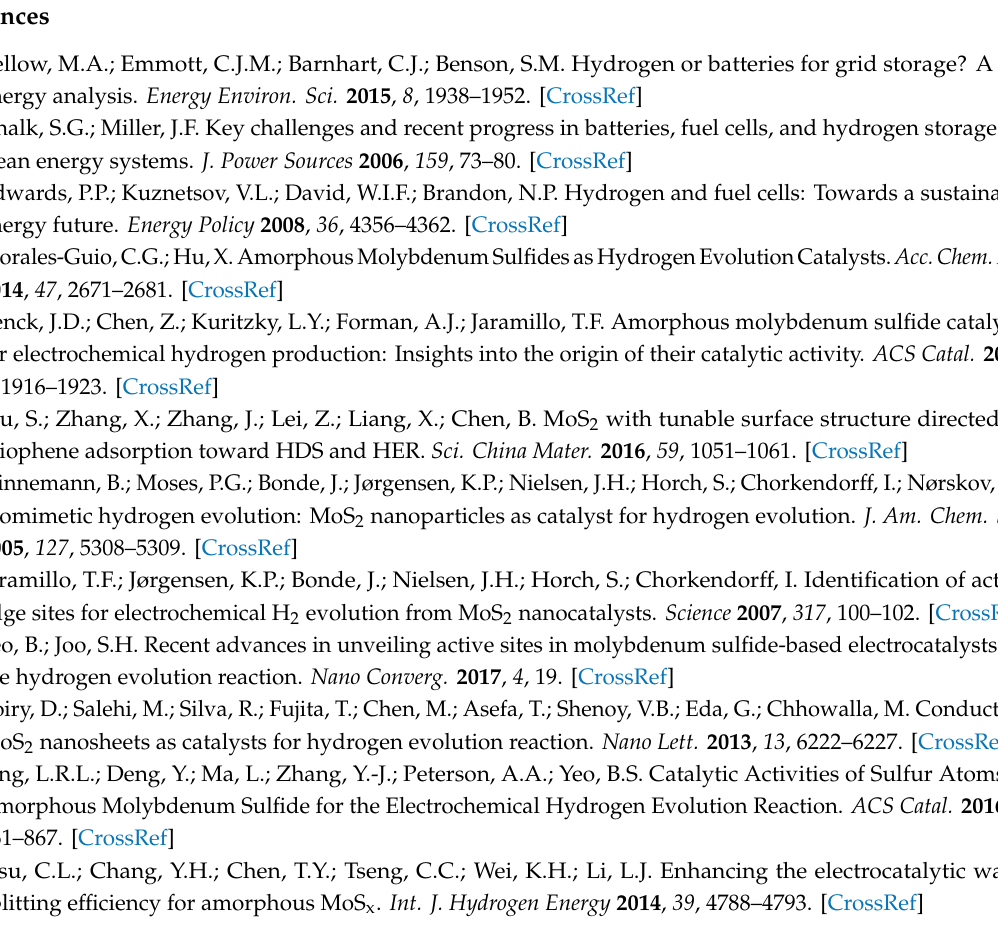
Figure S1: Rietveld refinement of MoS 2 , Figure S2: Electron di ff raction pattern of MoS 2.6 and MoS 3.4 , Figure S3: HRTEM images of MoS 2 + δ used for the lattice parameter analysis in Table S5, Figure S4: HRTEM images of MoS 2 and their FFTs, Figure S5: Reduced FFT of HRTEM image from Figure 5 A & B, Figure S6: SEM images of MoS 2 and MoS 3.4 powder, Figure S7: Cyclic voltammetry of the two MoS x samples and MoS 2 , Table S1: Comparison of d hkl from XRD and SAD from Figures 2 and 3 for MoS 2 + δ with MoS 2 , Table S2: Goodness parameters and correction factor for the texture, Table S3: Refined lattice parameters and atom positions of MoS 2 , Table S4: Overview of the most intense lattice planes in electron di ff raction of MoS 2 , Table S5: Result from the FFT analysis of HRTEM images of MoS 2 + δ